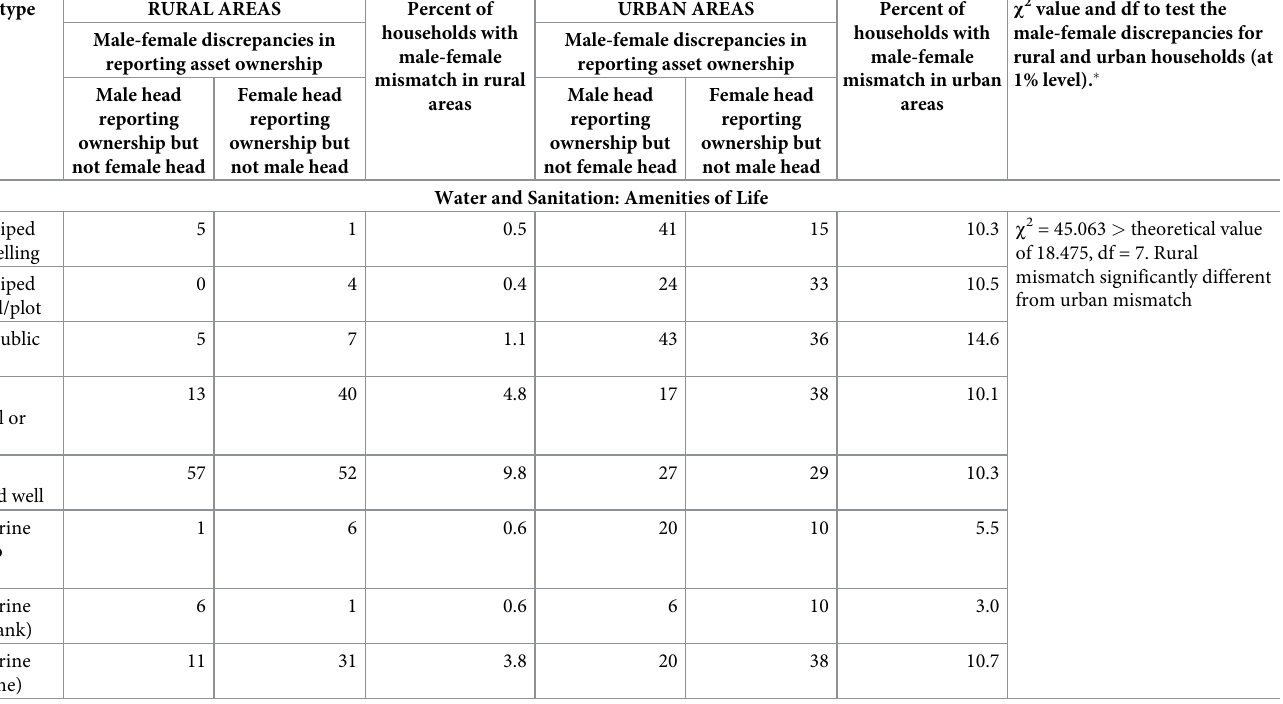
deviation in asset score (D) has been calculated by using the formula: